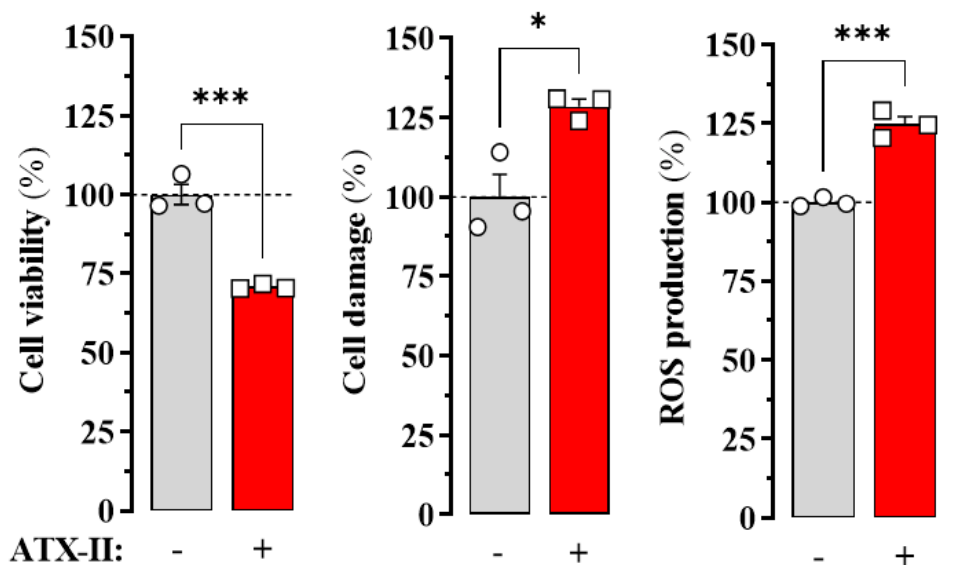
Figure 1. Effect of ATX-II on the viability of HL-1 cells. Cells were incubated in the absence (circles in grey columns,) or presence of ATX-II (30 nM) (squares in red columns) for 24 h before cell viability, cell damage and ROS production were monitored by MTT tetrazolium reduction (left panel), PI (middle panel), and DCF (right panel) assays, respectively (see Methods). The results are shown as percentage of viable cells, cell damage and ROS production in cells treated with saline (ATX-II -) and expressed as mean ± SEM of three independent experiments, each performed in triplicate. * p < 0.05, *** p < 0.001, Student’s t -test.